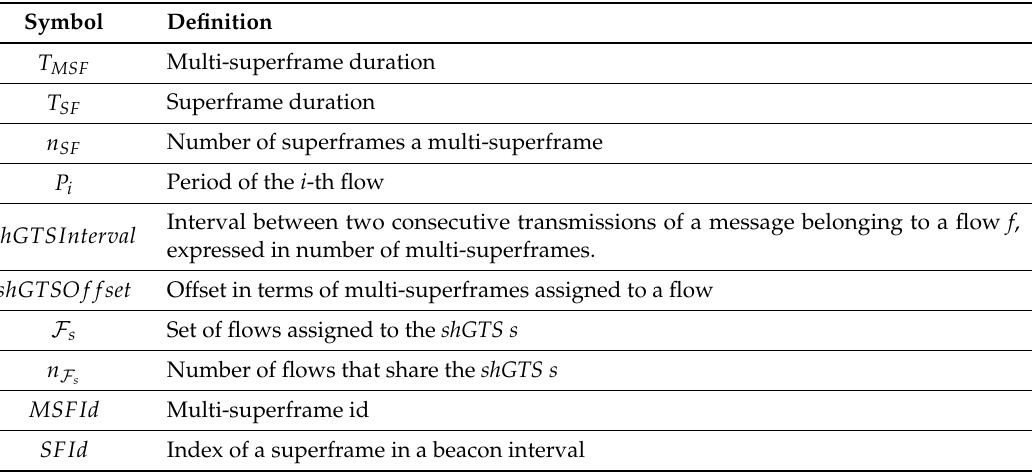
Table 1. Summary of